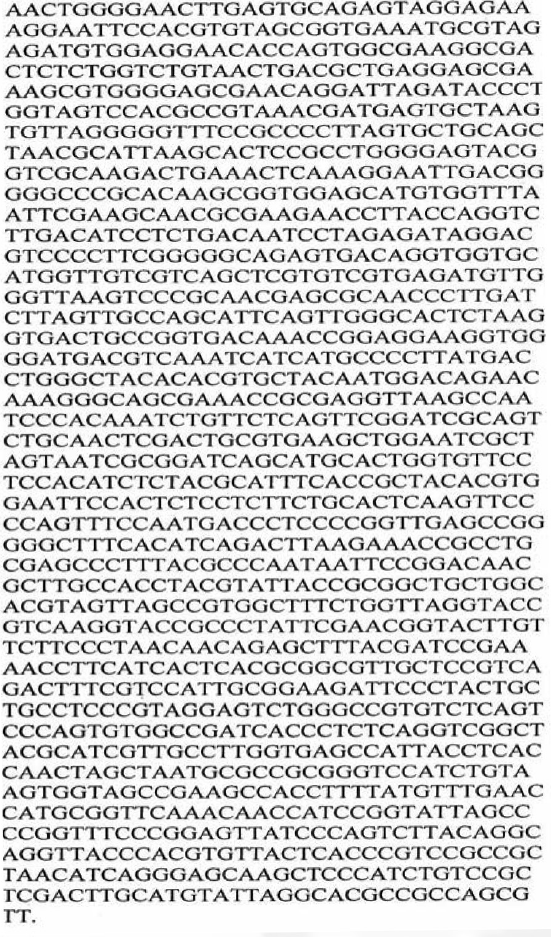
FIGURE 3 - The 16S rRNA sequence generated for isolate-2 had 1600 bases.